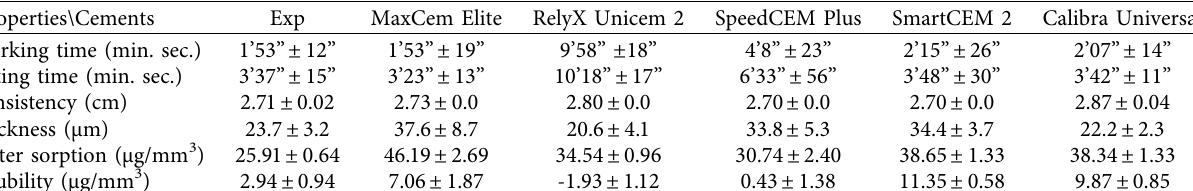
Table 2: Physical properties of self-adhesive resin cements.